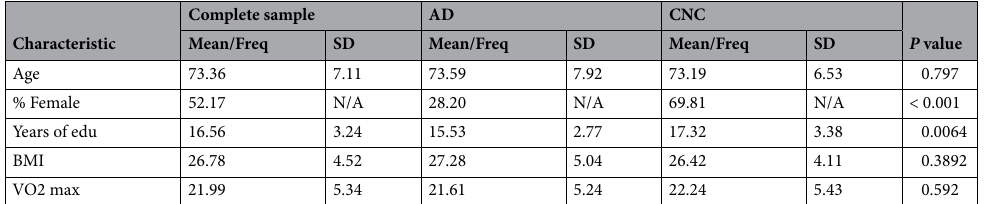
Table 1. Summary statistics for the complete, AD and CNC samples. No statistical difference between the AD and CNC groups are observed across age, BMI, or V0 2 max. However, AD group had a smaller percentage of females (28.2 vs 69.8 for CNC) and lower education (15.5 years vs 17.3 years for